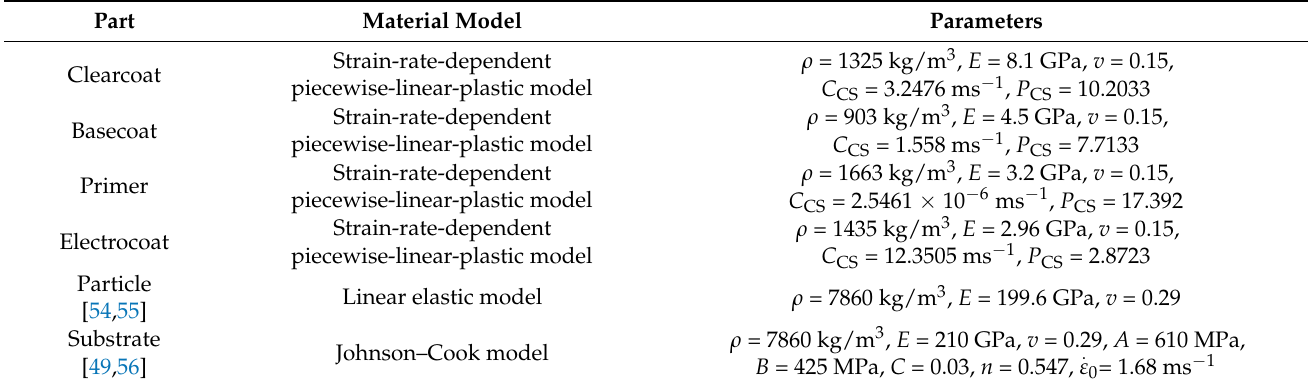
Figure 2. Meshes, main dimensions, and boundary conditions of the finite element model in the single-impact simulation of the automotive coating system. The particle has an initial impact velocity of 91.2 m/s. Table 3. Material models and parameters of the finite element